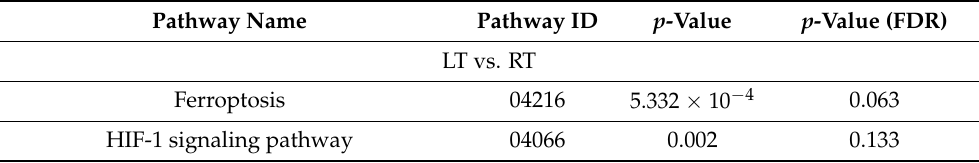
Table 5. Pathway analysis of regulated proteins in temporal and nasal quadrants 2 weeks after